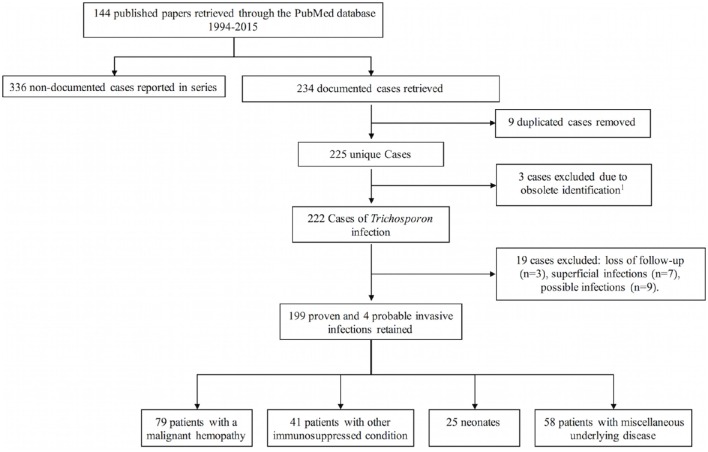
Flow diagram showing the cases retained after application of selection criteria. Trichosporon pullulans is now considered Gueomyces pullulans.